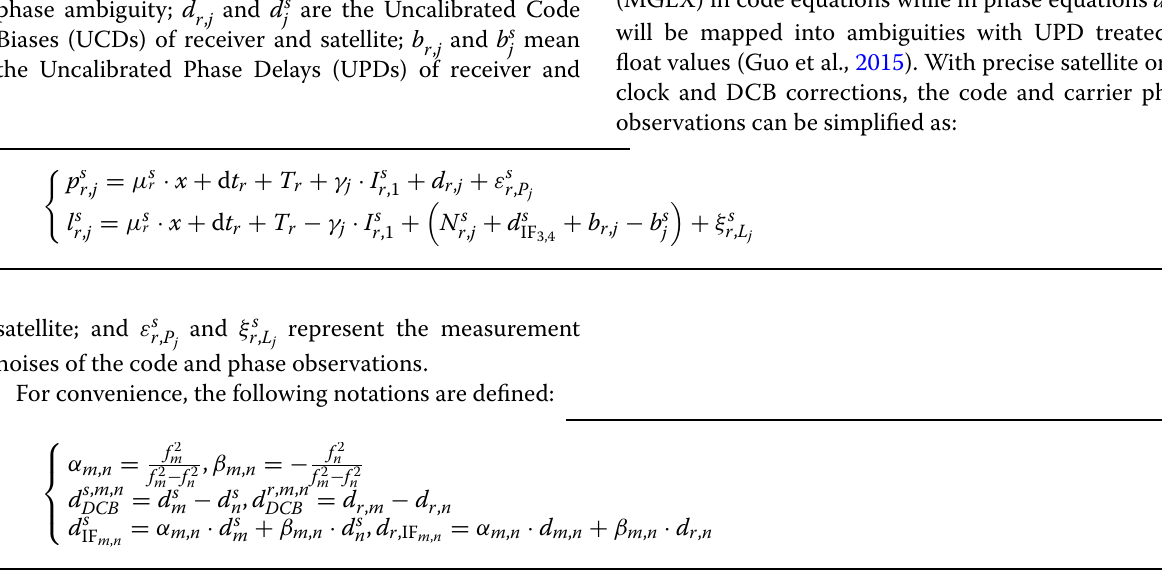
FF1: model using five‑frequency UC